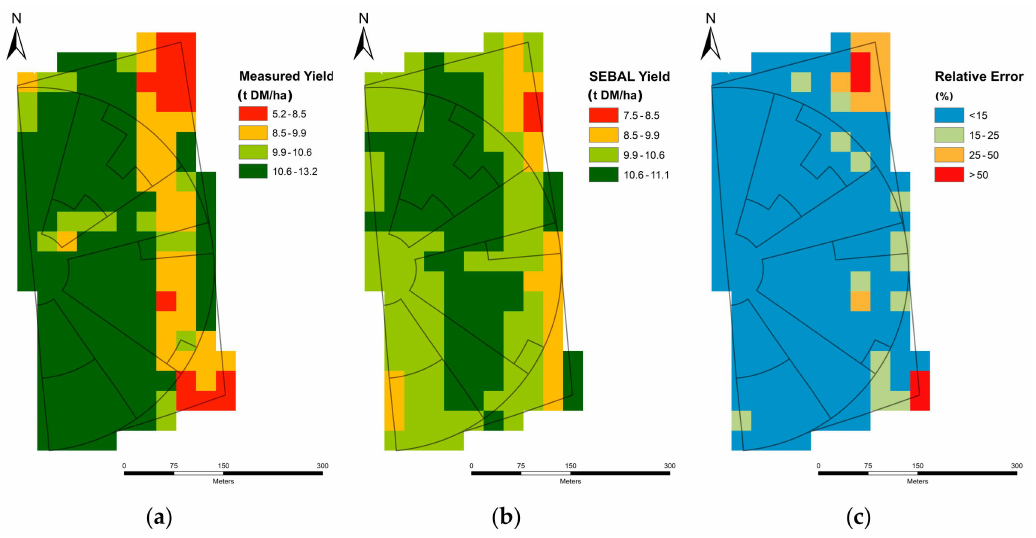
Figure 10. Measured ( a ) and SEBAL ( b ) yield maps, relative error map ( c ) between measured and SEBAL yield